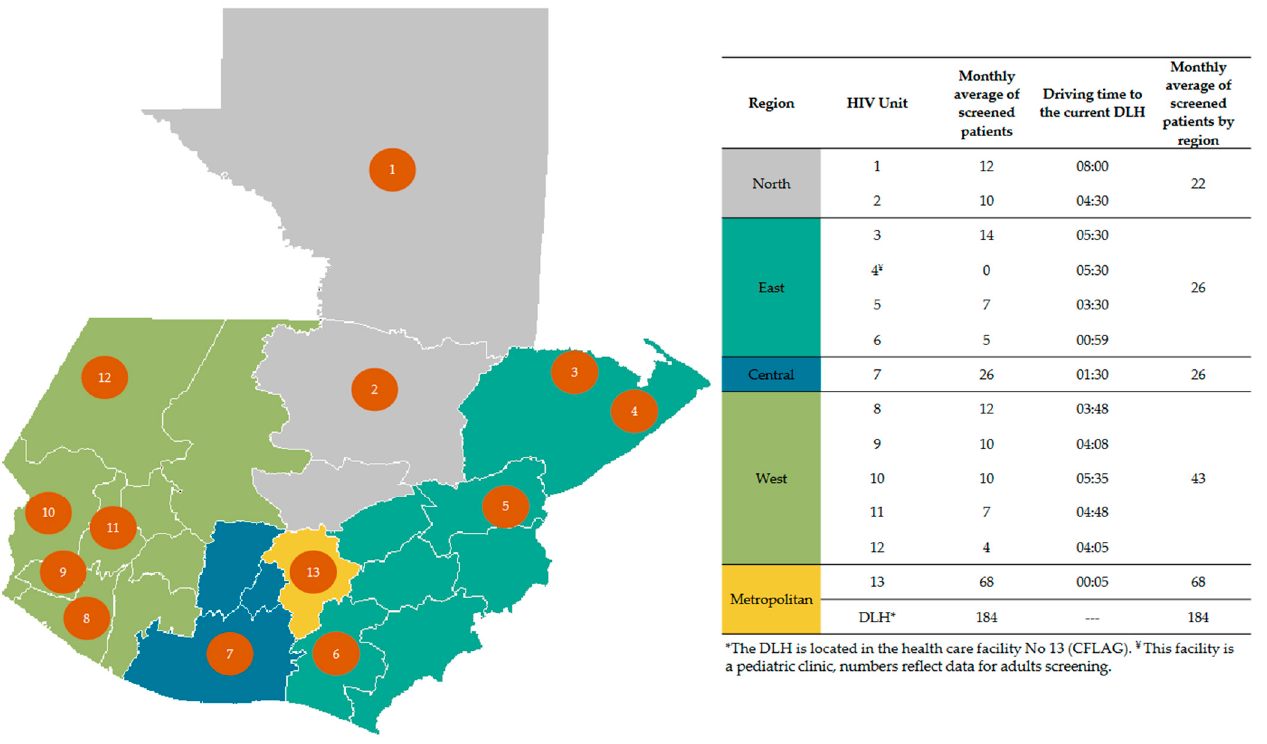
Figure 1. Summary of the HIV units of the network, average number of screened patients in every location, and driving time to the diagnostic laboratory hub.